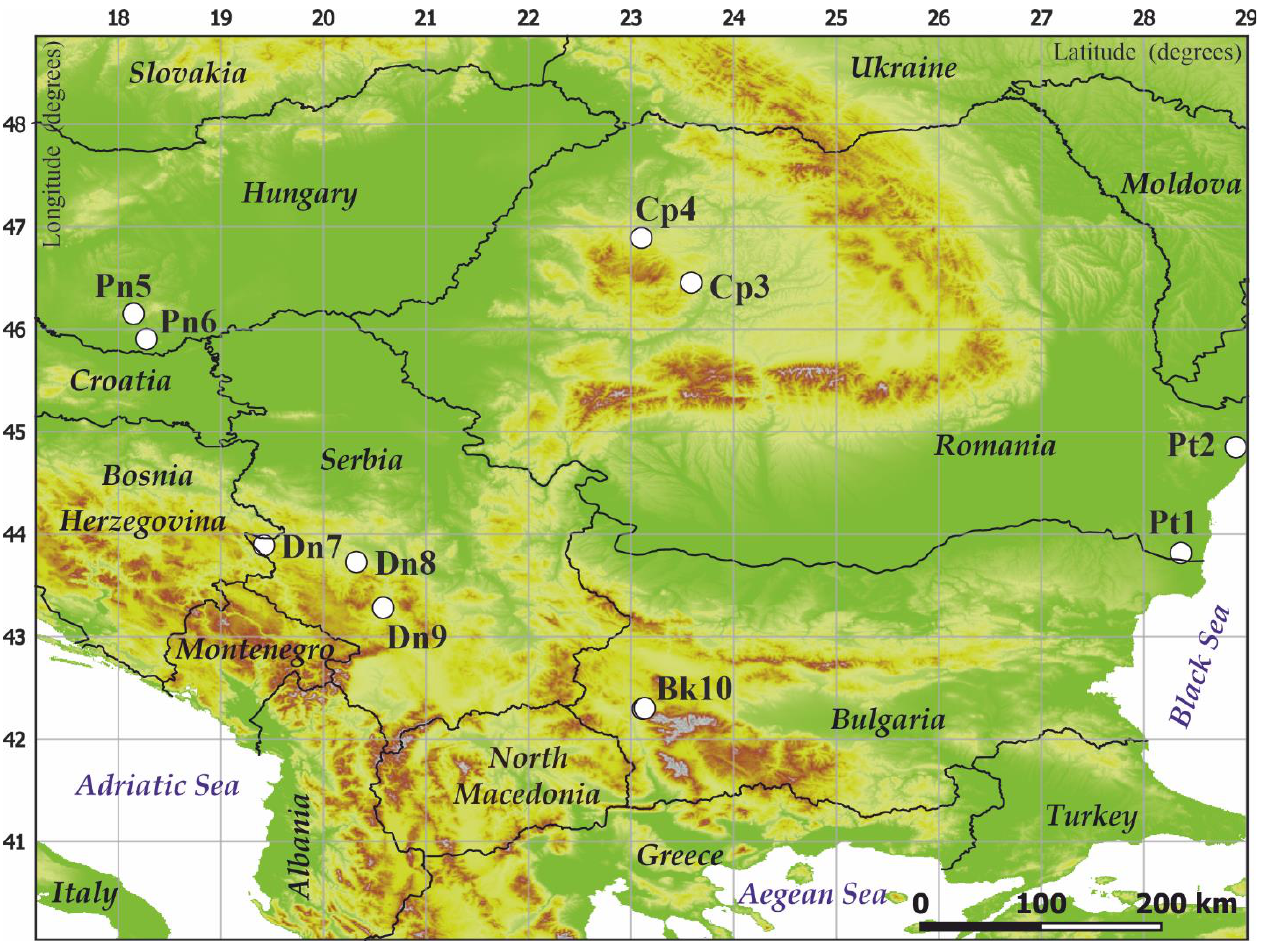
Figure 1. Location of the sites where the relevés considered in this study were performed. The group of letters and numbers within the labels refer to the identity of the region and study site, respectively. Pt = Pontic; Cp = Carpathian, Pn = Pannonian; Dn = Dinaric; Bk = Balkan; 1—Cotu Văii; 2—